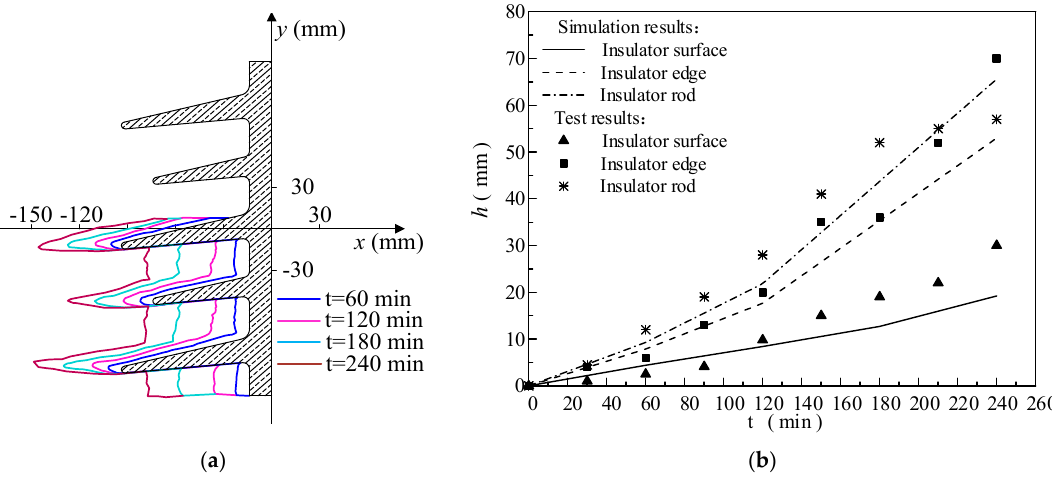
Figure 12. ( a ) Vertical section of icing insulator with the icing removed from the top for comparison; ( b ) The icing thicknesses at three positions on the insulator in the central vertical section of the largest shed.